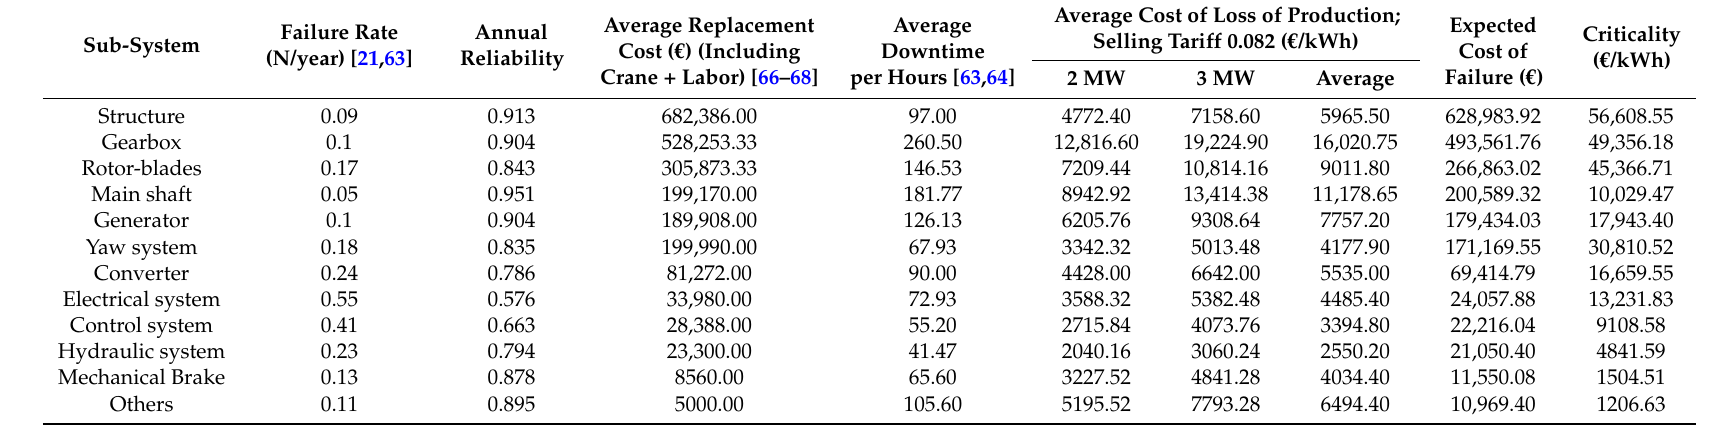
Table A2. Data used to calculate the expected failure costs generated in a 2–3 MW wind turbine